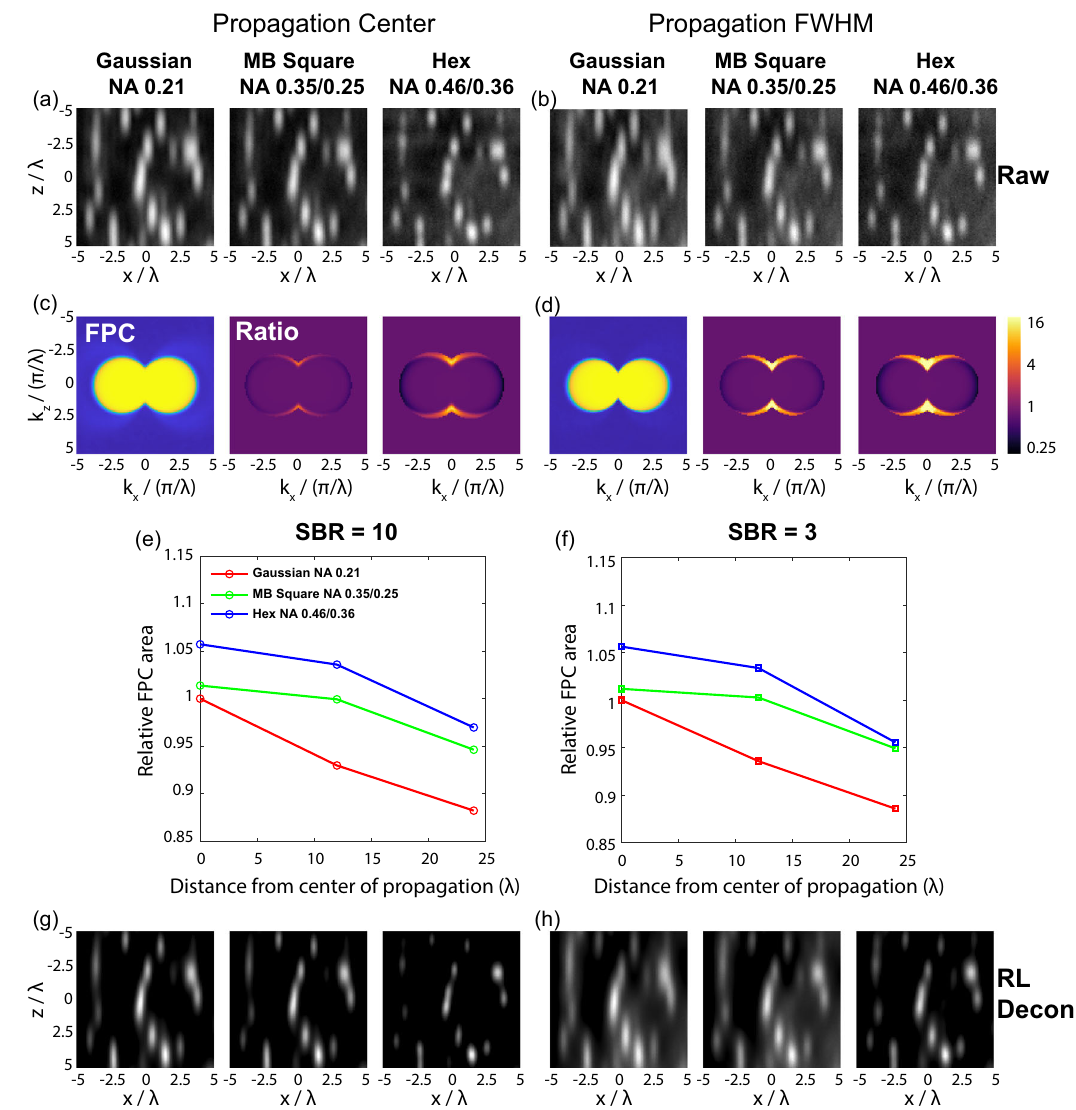
Fig. 3 | Simulated images of point emitters and resolution quanti fi cation. a , b RepresentativerawxzsliceimagesatthefocusandpropagationFWHMofeach beam type. c , d Fourier plane correlation (FPC) images calculated based on two copies of independently simulated images in ( a , b ). For the FPC images of MB- square and hexagonal lattices, we show the ratio of the FPC amplitude relative to the Gaussian within the cutoff range of 1/7. e , f Relative integrated FPC area of the